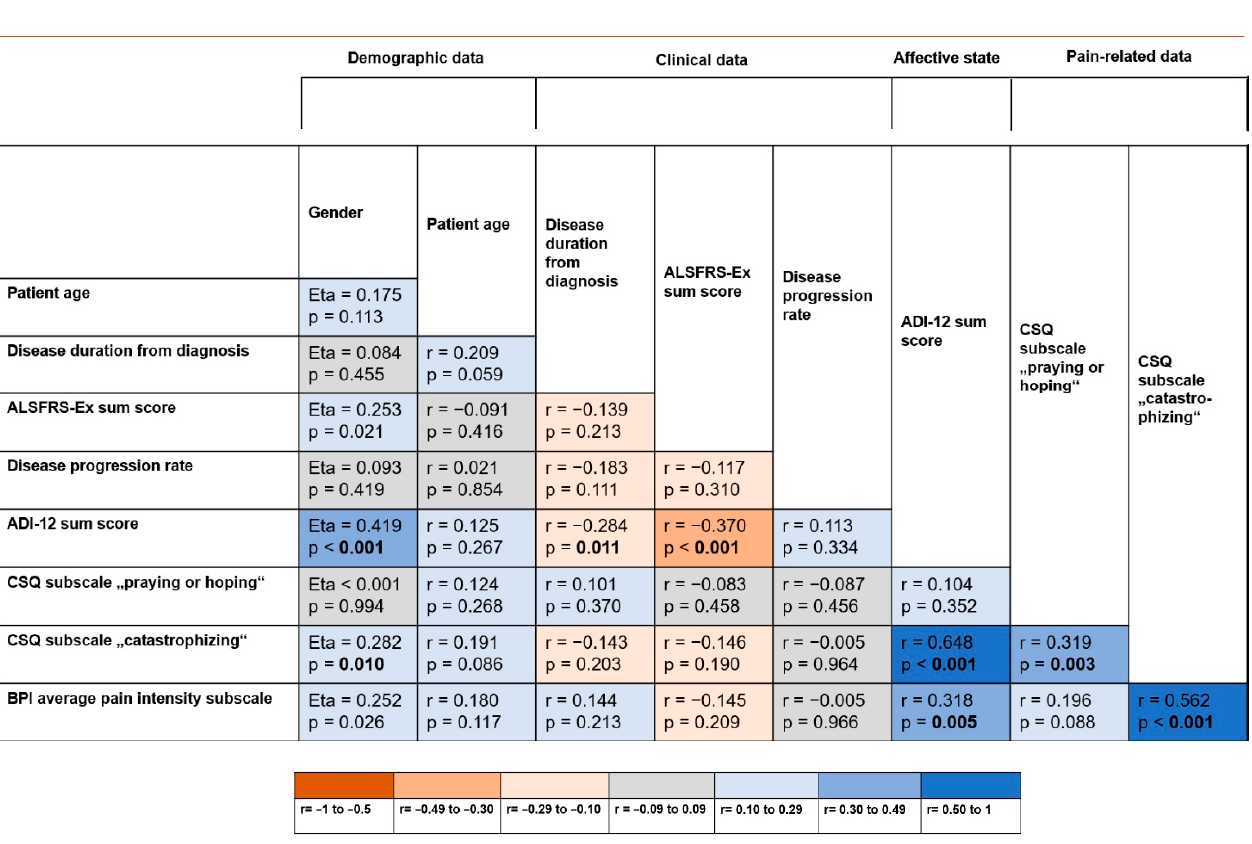
Figure 2. Correlation matrix presenting the correlations between demographic and clinical data as well as the results of the patient ‐ reported outcome measures referring to the ALS patients with pain. For visualization of the degree of the association between the variables, a color scale from shades of red to shades of blue was used, which refers to the interpretation of effect sizes in terms of weak (0.10 to 0.29), moderate (0.30 to 0.49) and strong (0.50 to 1.00). Referring to the four groups of varia ‐ bles (demographic data, clinical variables, measure of affective state and pain ‐ related variables), Bonferroni ‐ adjusted p ‐ values: 0.05/4 = 0.0125 were deemed significant and are boldfaced.